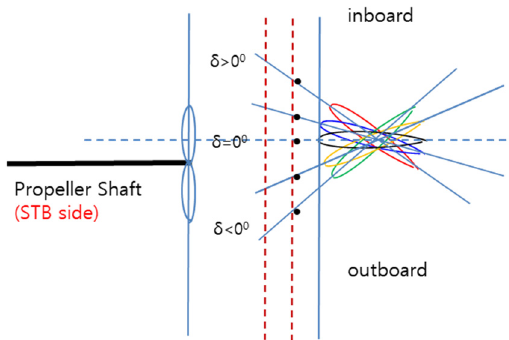
Figure 14. Definition of rudder deflection angle: when viewed from above, when rotating clockwise + rudder deflection angle, and when rotating counterclockwise − rudder deflection angle. In this study, 3-D LDV measurements were performed on the full-spade rudder mod- els under the following test conditions.